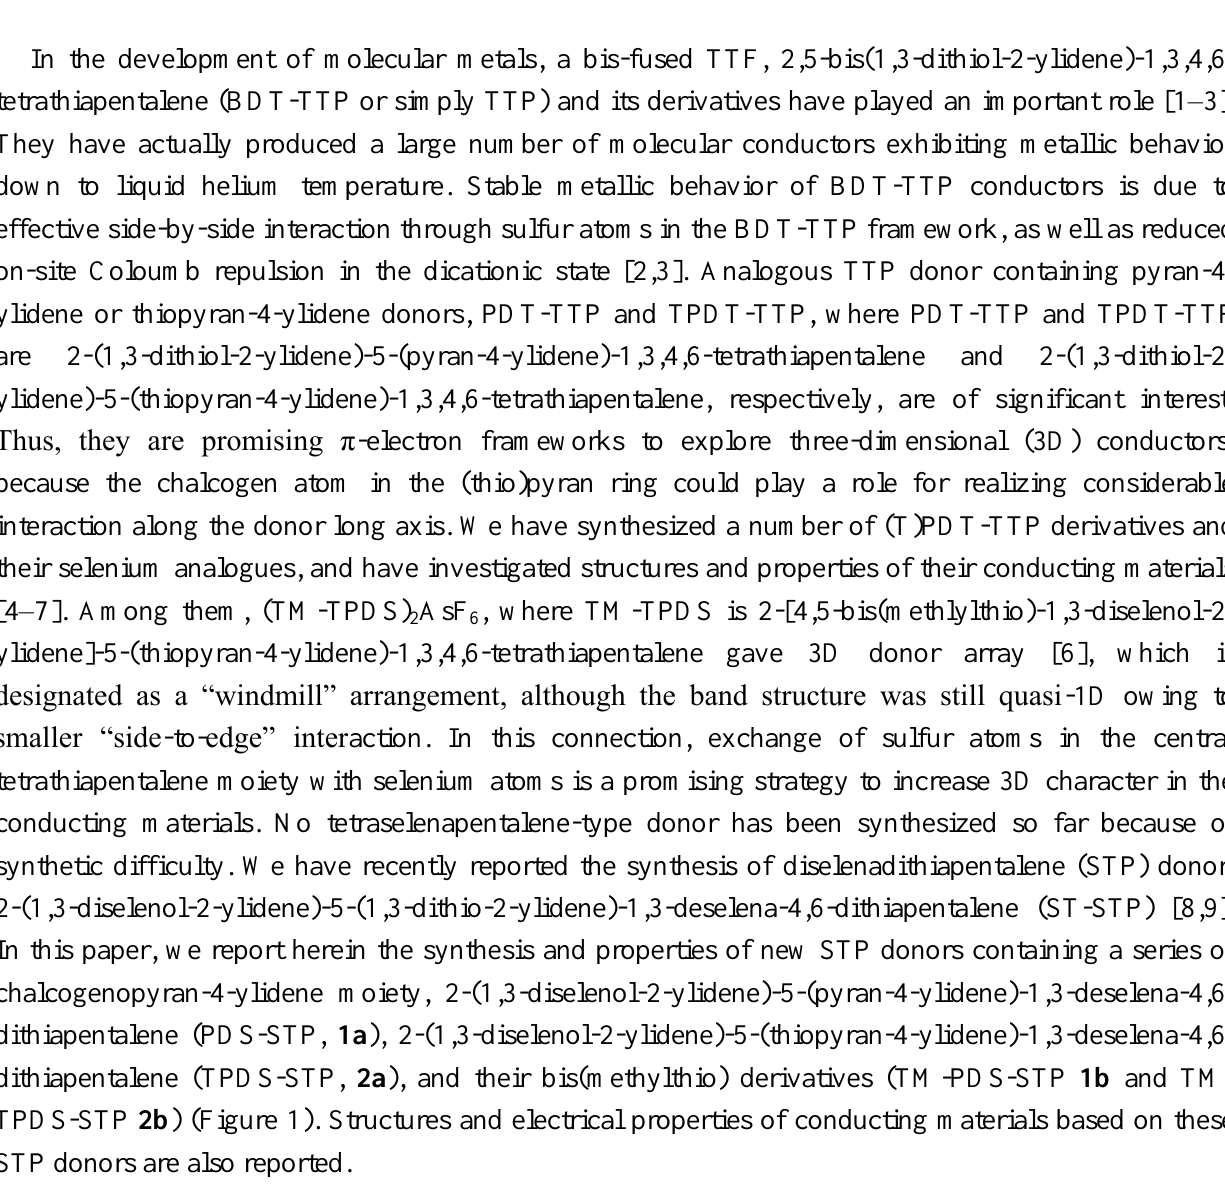
Figure 1. Molecular structures of BDT-TTP derivatives and their